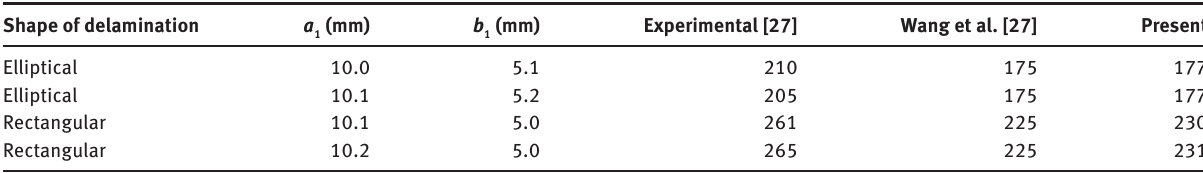
Table 4: Comparison of critical buckling temperature Δ T plates with different